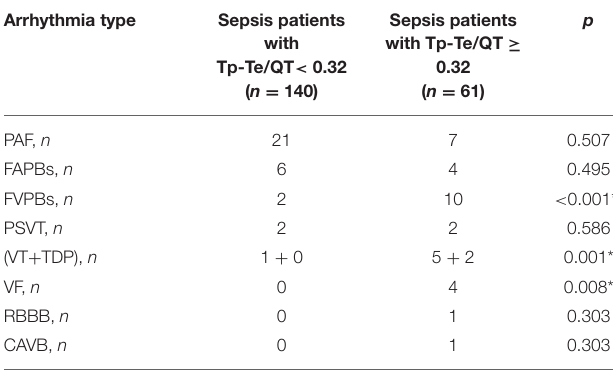
TABLE 8 | Types of new arrhythmia in patients with sepsis with different